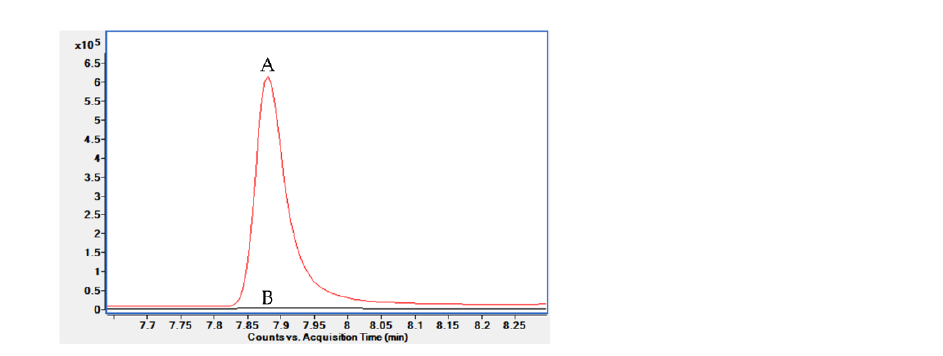
Figure A2. Overlay of the acetic acid in selected ion monitoring (SIM) chromatograms of the (A) water blank with DE for extraction and (B) water blank with MTBE for extraction.